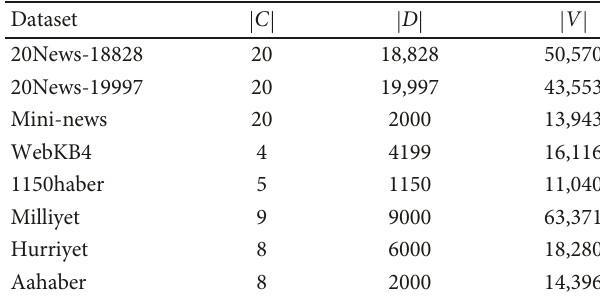
Table 1: Number of classes ( C ), documents ( D ), and words ( V ) in each